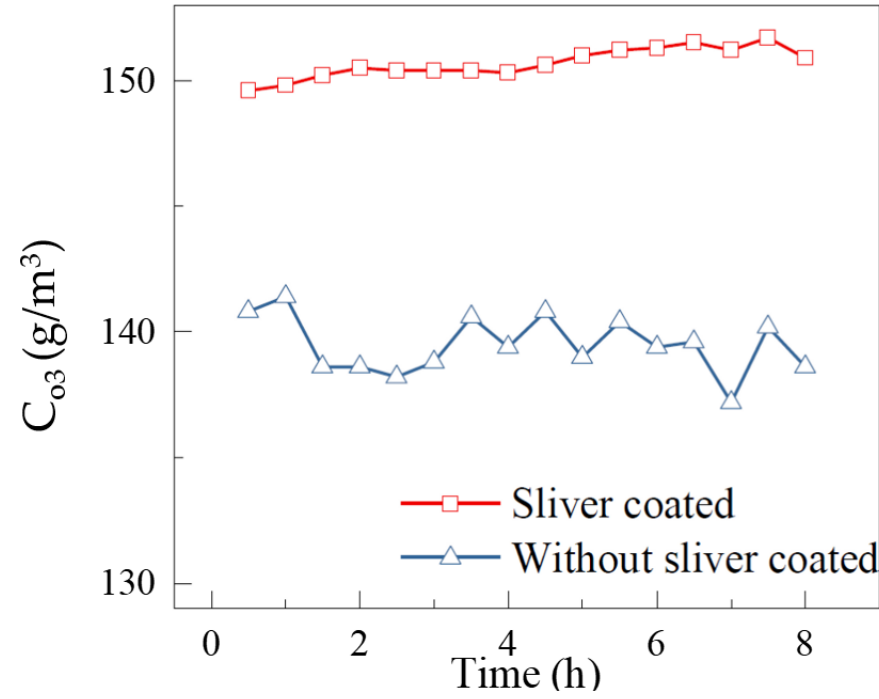
Figure 12. Dependence of ozone concentration on the running time ( F in = 1 L/min, P = 90 W).